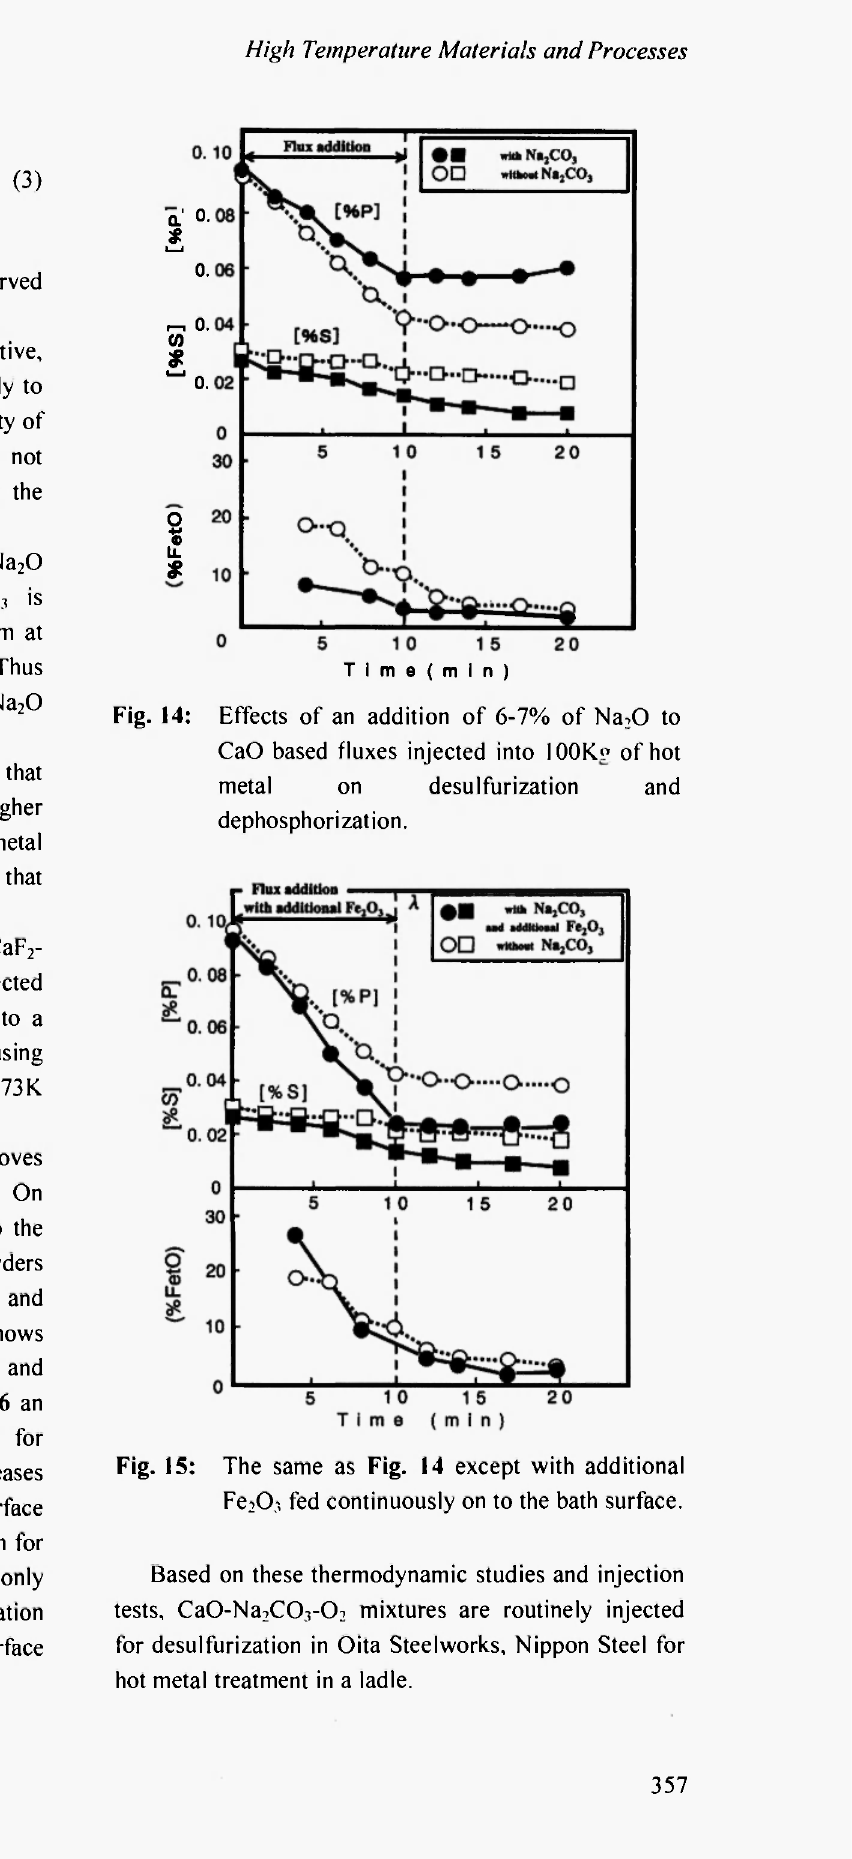
Based on these thermodynamic studies and injection tests, Ca0-Na 2 C0 3 -0 2 mixtures are routinely injected for desulfurization in Oita Steelworks, Nippon Steel for hot metal treatment in a